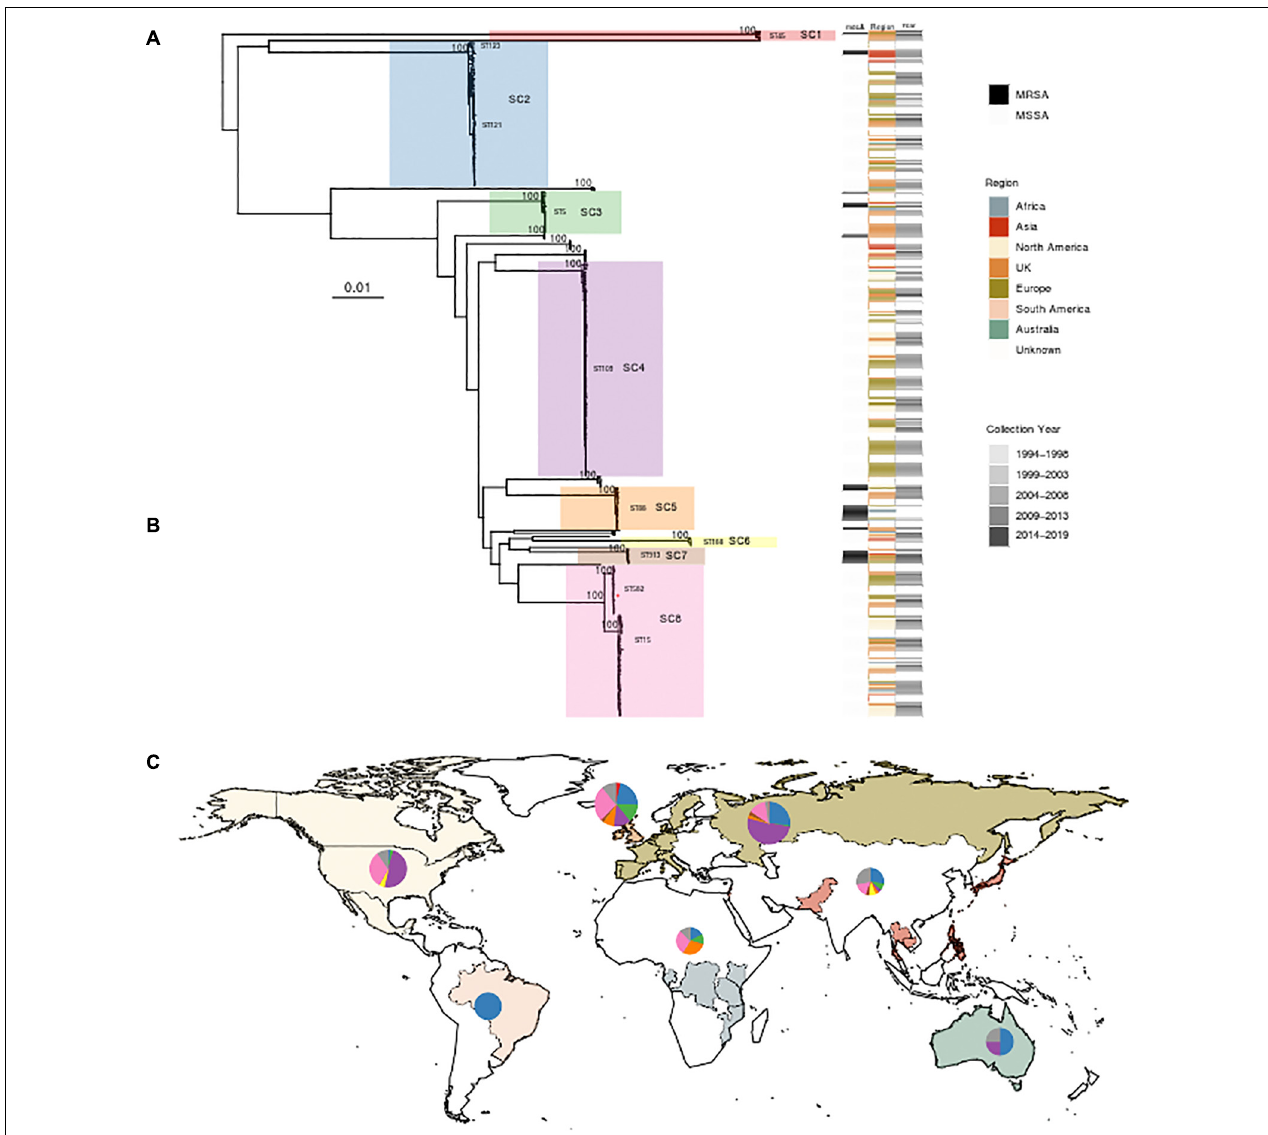
FIGURE 2 | Phylogenetic analysis and global distribution of 436 Staphylococcus aureus isolates that possess the gene encoding exfoliative toxin A ( eta ). (A) Maximum likelihood (ML) phylogeny of 436 isolates, including three strains from this study, inferred from a core genome alignment of 1,794 genes totaling 1,615,001 nucleotides in length and containing 63,517 single-nucleotide polymorphisms. Bootstrap values showing statistical support for tree topology are annotated on the branches. Lineages [sequence clusters (SCs)] as identified through statistical analysis of population structure are highlighted on the phylogeny. A red star on SC8 indicates the location of the ST582 outbreak isolate MSSA_SSSS_01. The SC and multilocus sequence types (MLST) are shown next to lineages. Strains possessing mecA , geographic region of isolation, and year of collection are indicated on the heatmap to the right of the phylogeny. (B) Table showing the distribution of 436 strains among SCs with the color corresponding to the heatmap in panel A. The MLST types comprising each SC are also listed. (C) World map illustrating sampled countries and regions with respective proportion of isolates belonging to each SC. Countries are colored according to region membership, and the region colors correspond to the heatmap in panel (A) and table in panel (B) . The proportion of isolates belonging to major SC is indicated by the pie chart. The United Kingdom is presented separately from the rest of Europe due to the number of sampled strains and the difference in population structure. The size of the pie chart is scaled by the proportion of the total number of strains sampled from each region. Mapping was performed using R package maps